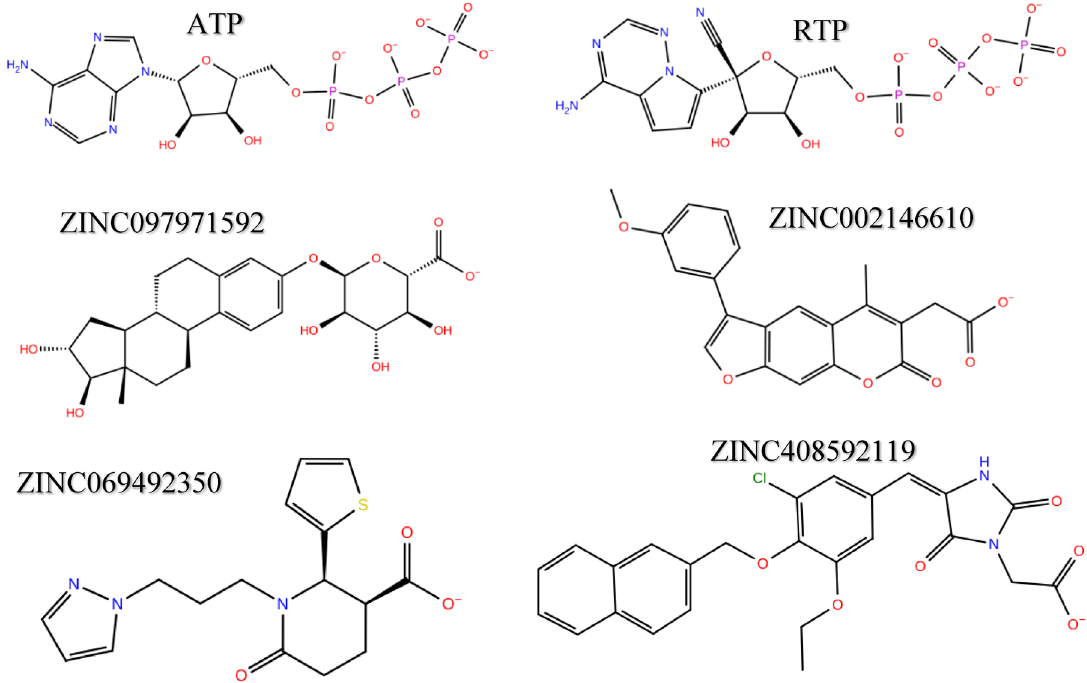
Figure 6. The 2D structures of RTP, ATP and the top four selected ZINC compounds.